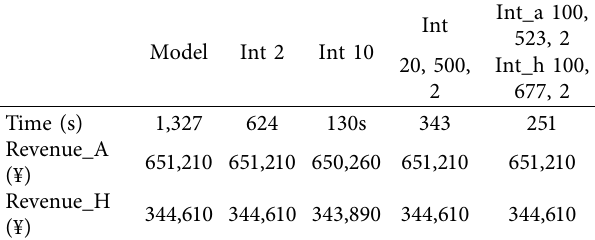
Table 10: Model time